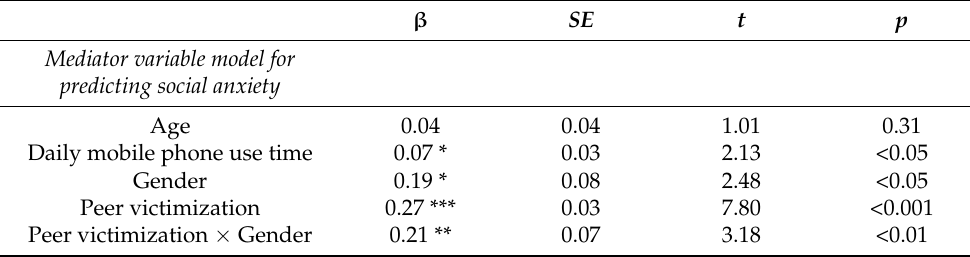
Table 4. Moderated mediation analysis.